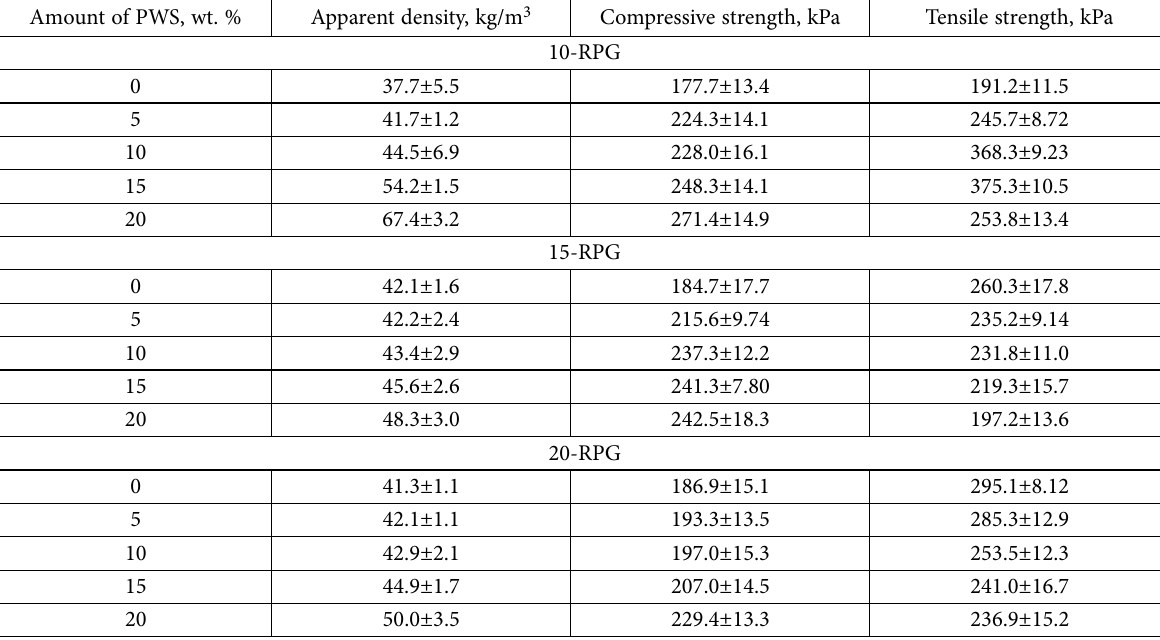
Table 5. Apparent density and mechanical properties of RPG extended and PWS filled polyurethane foam composites Amount of PWS, wt.